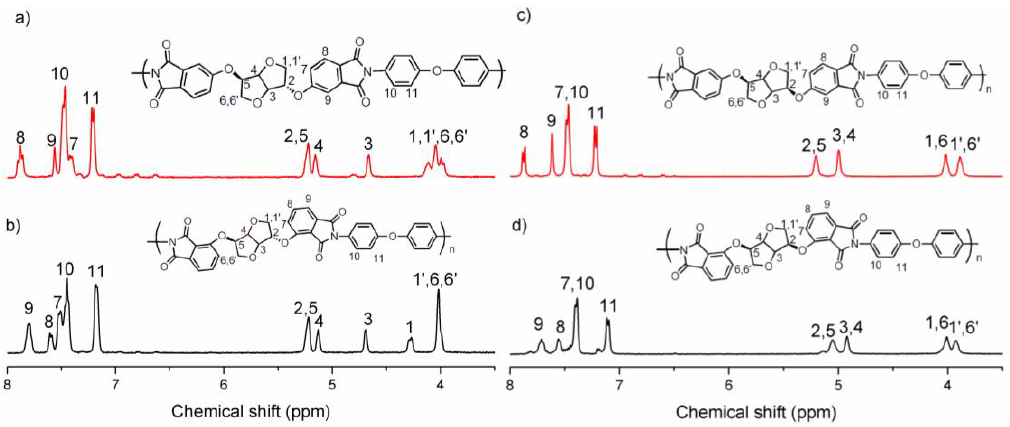
Figure 4. Representative 1 H NMR spectra of isohexide-derived PEIs in DMSO- d 6 . ( a ): 4,4′-ISDPA/ODA; ( b ): 3,3′-ISDPA/ODA; ( c ): 4,4′-IMDPA/ODA; ( d ): 3,3′-IMDPA/ODA.